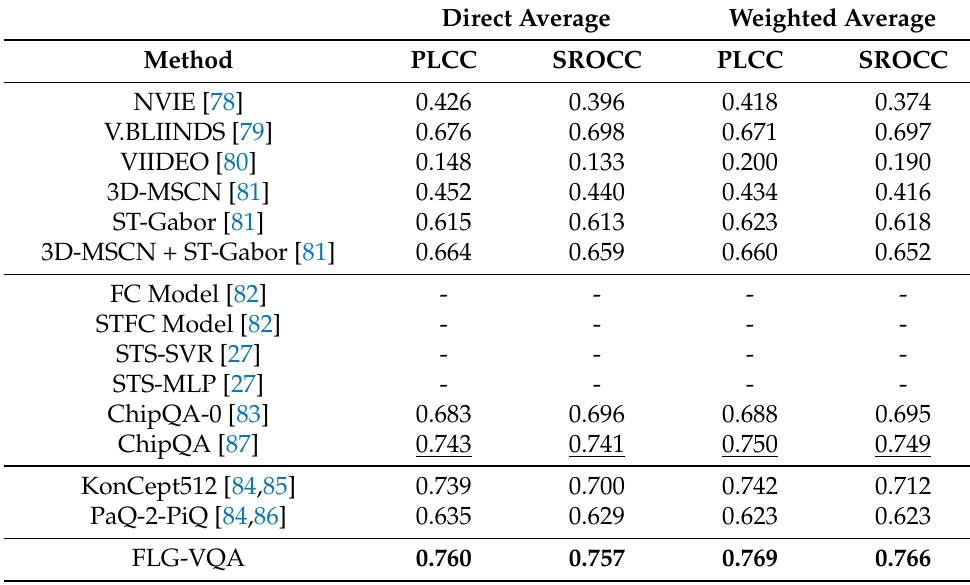
Table 5. Comparison of FLG-VQA with the state-of-the-art methods using the direct and weighted averages of the PLCC and SROCC values measured on the KoNViD-1k [16] and LIVE VQC databases